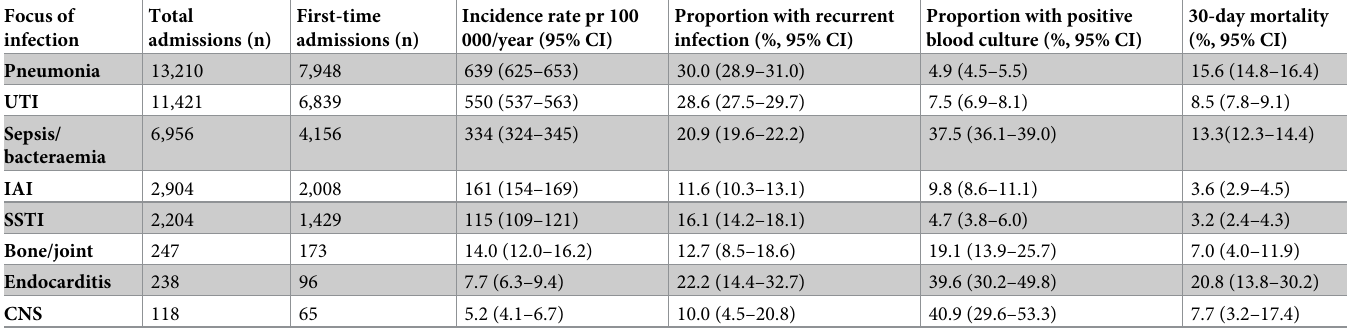
Table 2. Summary of results divided into eight different foci of infection. Focus of